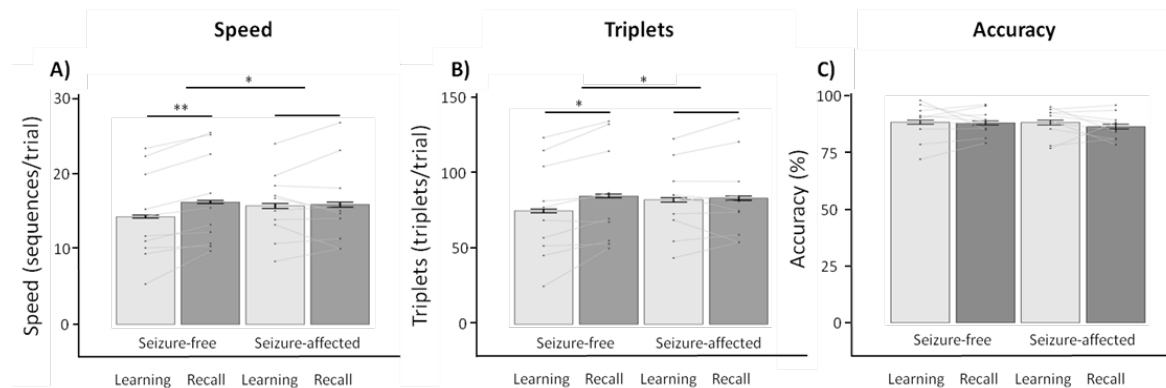
Figure 3. Exploratory within-subject contrasts ( n = 10) following a seizure-free and seizure-affected retention period for patients with temporal lobe epilepsy ( M ± SE ). Note that error bars have been corrected to represent within-subject variability. Contrasting performance between learning and recall sessions following a seizure-free or seizure-affected retention period ( A – C ) showed performance improvements from learning to recall for speed and triplets. Furthermore, performance improvements were higher for a seizure-free as compared to a seizure-affected retention period. * p < 0.050; ** p < 0.001.